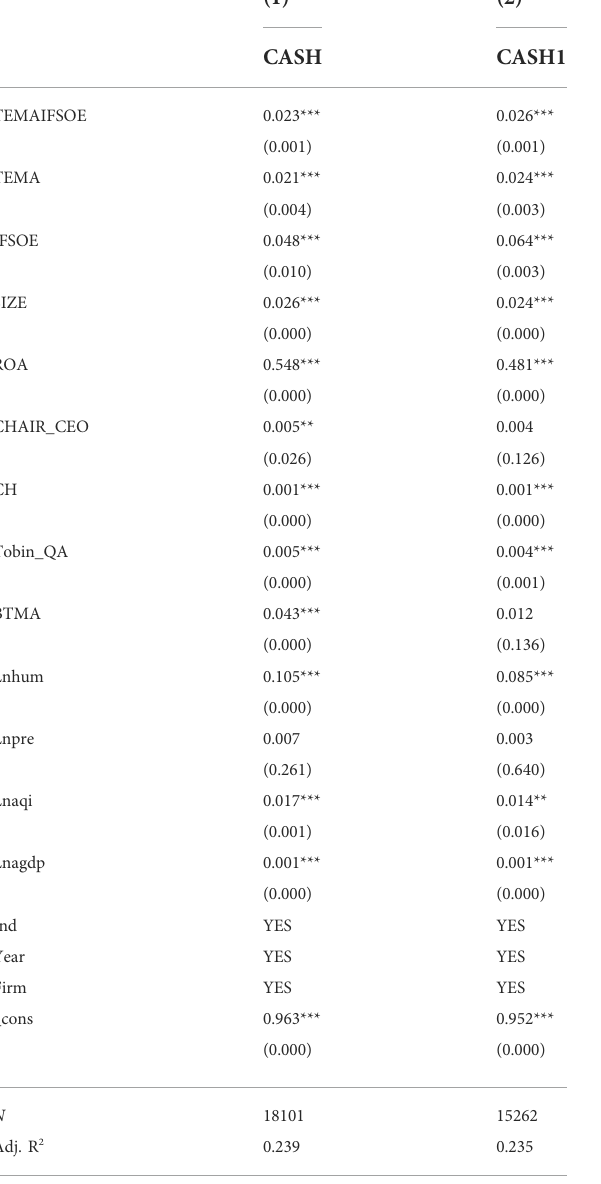
TABLE 12 Climate change, property rights, and corporate cash holdings.